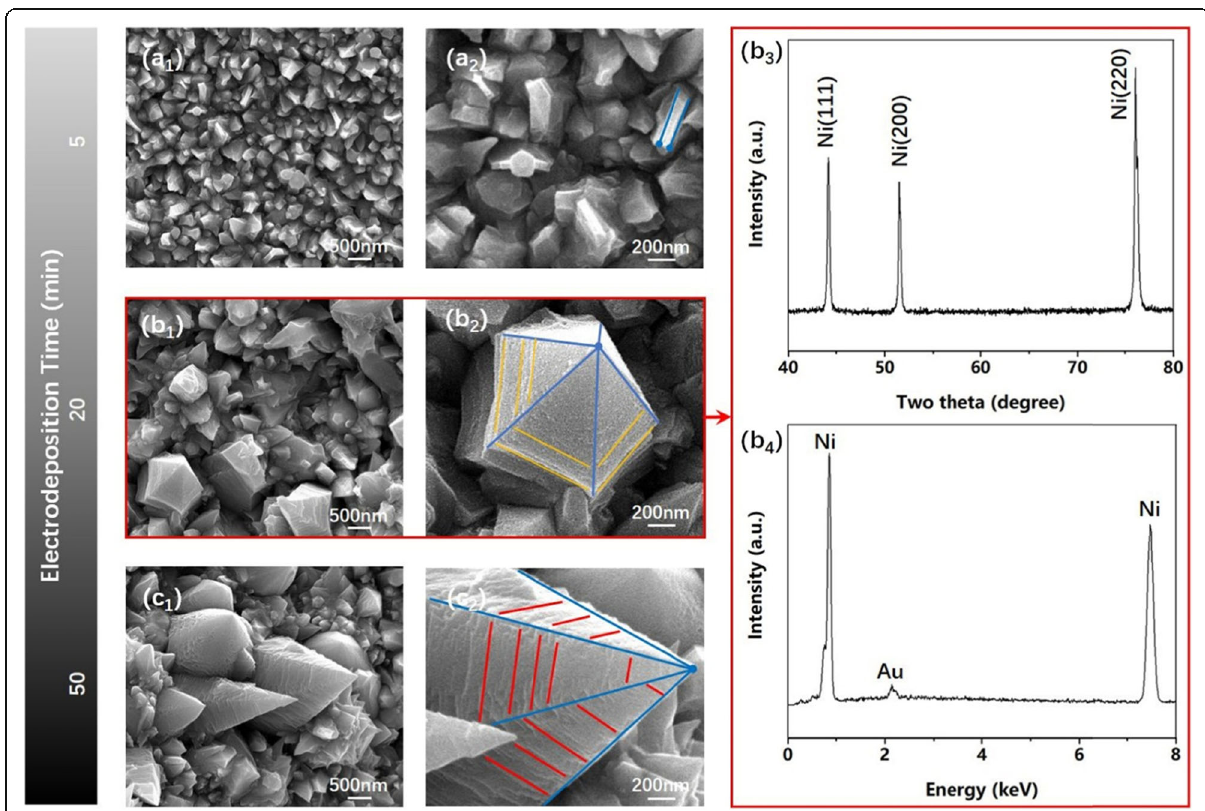
Fig. 2 Low-magnification SEM images on the surface morphology of Ni nanocones with different electrodeposition time ( a 1 , b 1 , c 1 ) and their high-magnification SEM images ( a 2 , b 2 , c 2 ), respectively. XRD pattern ( b 3 ) and EDS pattern ( b 4 ) of Ni 370